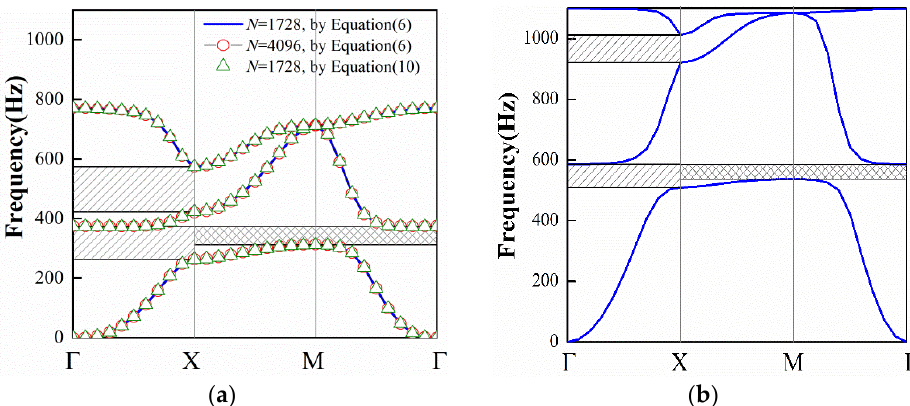
Figure 3. The real band gap diagram for the phononic plate: ( a ) with external fluid loading; ( b ) with- out the fluid loading. N denotes the number of